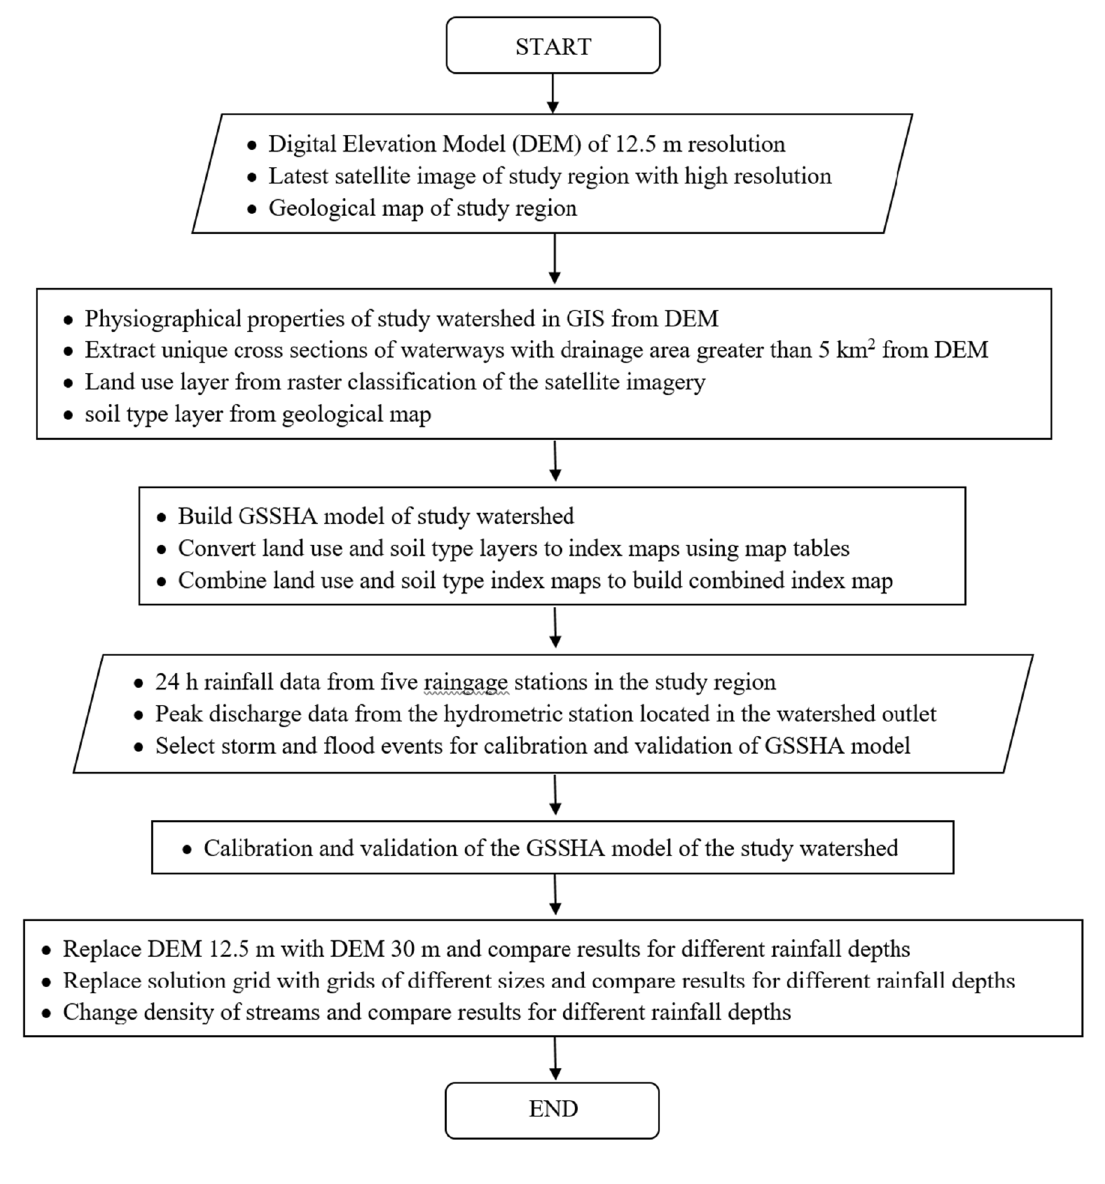
Fig. 2 Flowchart for the current